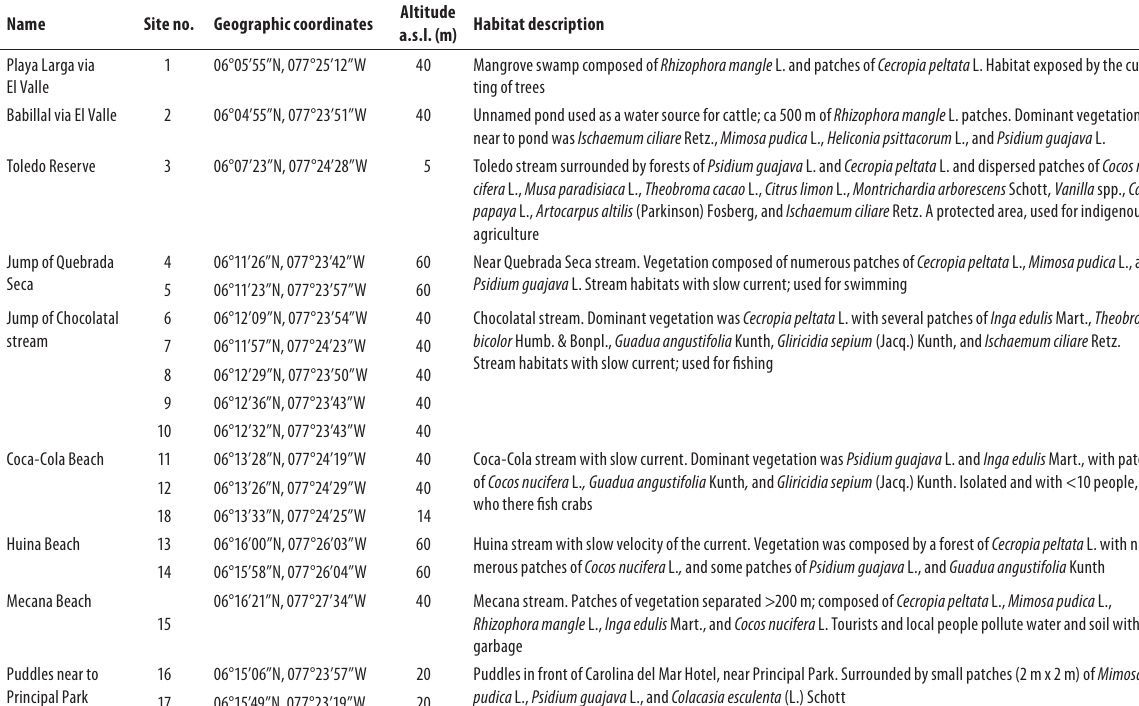
Table 1. Sites visited in Bahia Solano. The site number correspond to numbers on the map (Fig. 1). Name Site no. Geographic